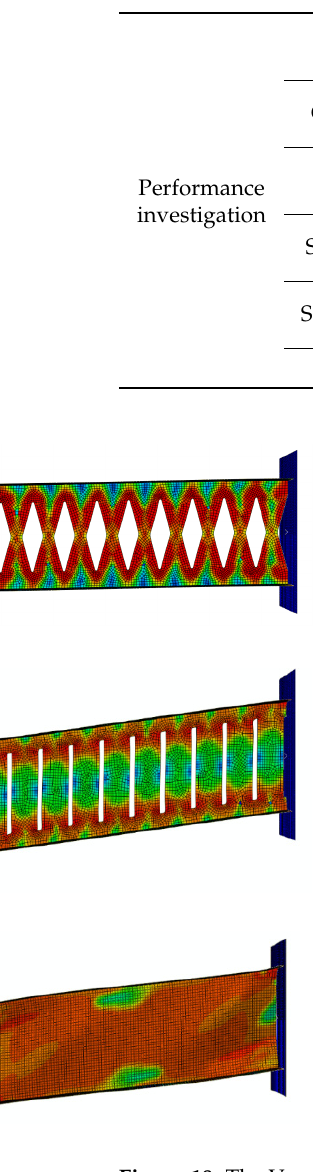
Figure 18. The Von-Mises stress, and stress concentration areas for SRLs at 0.08 drift ratio. Table 3. The mode of behavior for SRLs up to at 0.08 drift ratio.